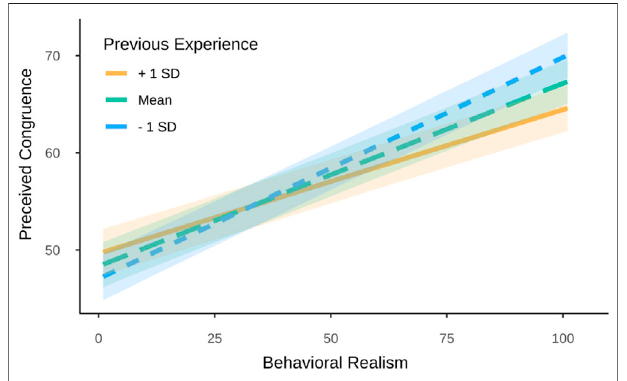
FIGURE 12 | Moderation effect of previous experience on the relationship between behavioral realism and perceived congruence.